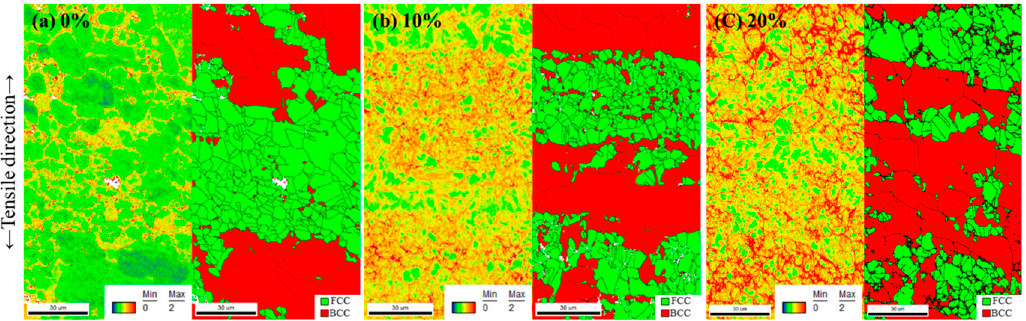
Figure 4. KAM and phase map of LDX-2101 steel of ( a ) as-received condition, ( b ) 0.1, and ( c ) 0.2 of tensile strain.